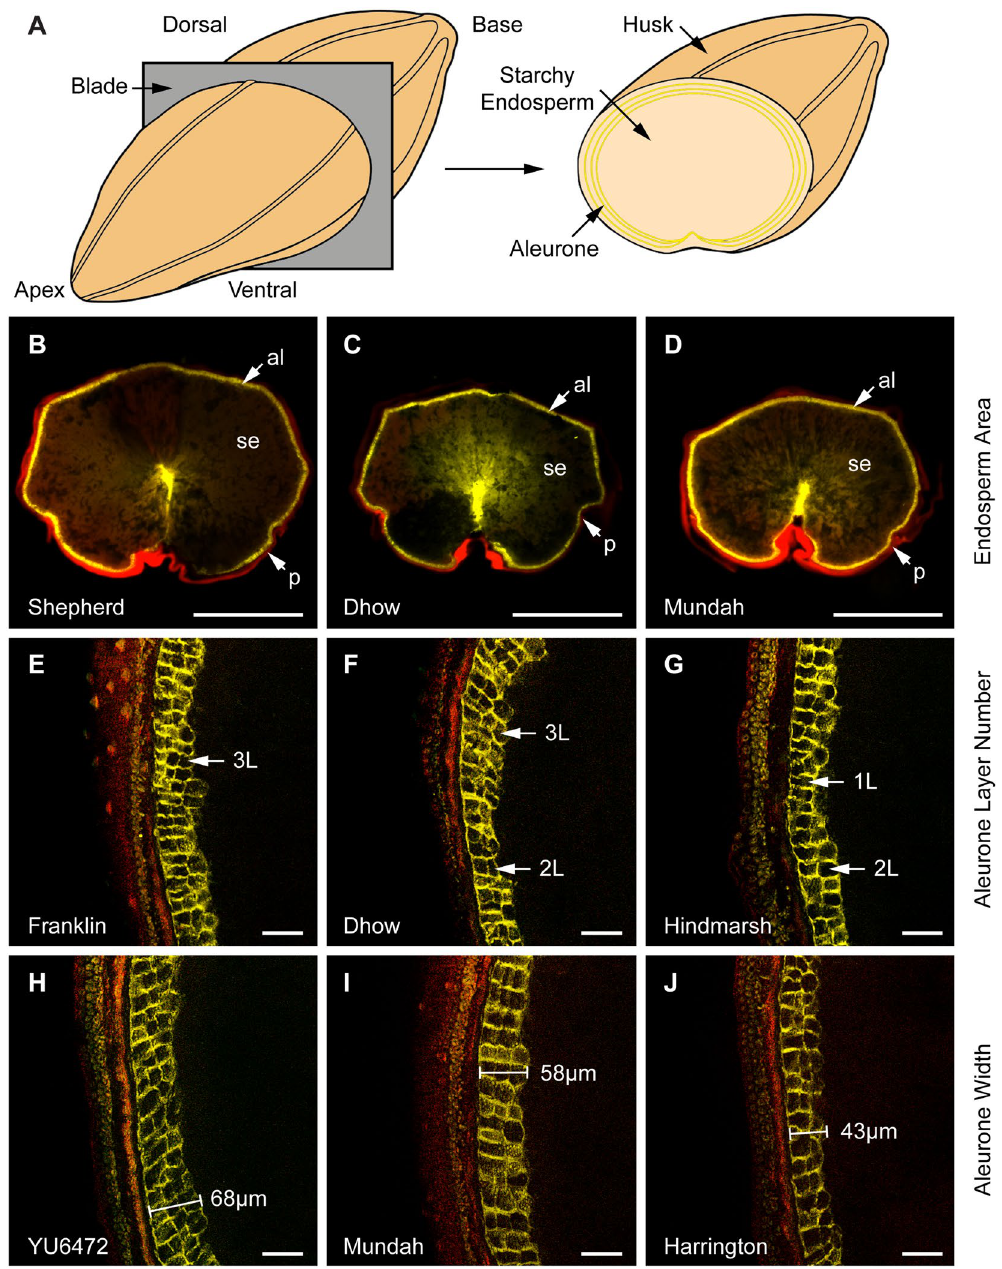
Figure 1. Representation of the transverse sectioning process used to image barley aleurone tissue by fluorescent microscopy. ( A ) Schematic representation of barley grain sectioning prior to microscopy. The different tissue layers are indicated. ( B – D ) Wholegrain transverse sections viewed at 1 × magnification using Zeiss Filter sets 46 (false-coloured red) and 49 (DAPI; false-coloured yellow). The panels show grain exhibiting differences in transverse starchy endosperm area in decreasing order. The pericarp/husk (p), starchy endosperm (se) and aleurone (al) tissues are indicated. Scale bar = 1 mm. ( E – G ) Magnified views of the aleurone layers at 20 × magnification using a Zeiss Apotome.2. Panels are arranged in decreasing order based on the average number of aleurone layers. Stacks of 3, 2 and 1 aleurone cell layers (L) are indicated. Scale bar = 50 µ m. ( H – J ) Examples of grain showing differences in aleurone width at 20 × magnification, arranged in decreasing order. Scale bar = 50 µ m. Genotype names are indicated in each